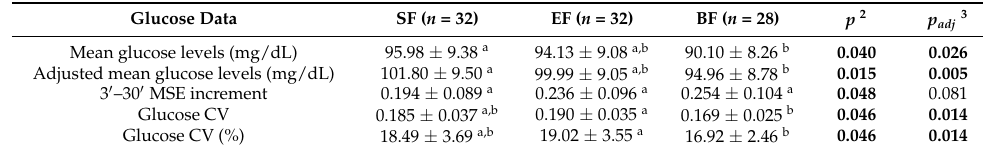
Table 3. Baseline glucose data at 6 years old considering study groups 1